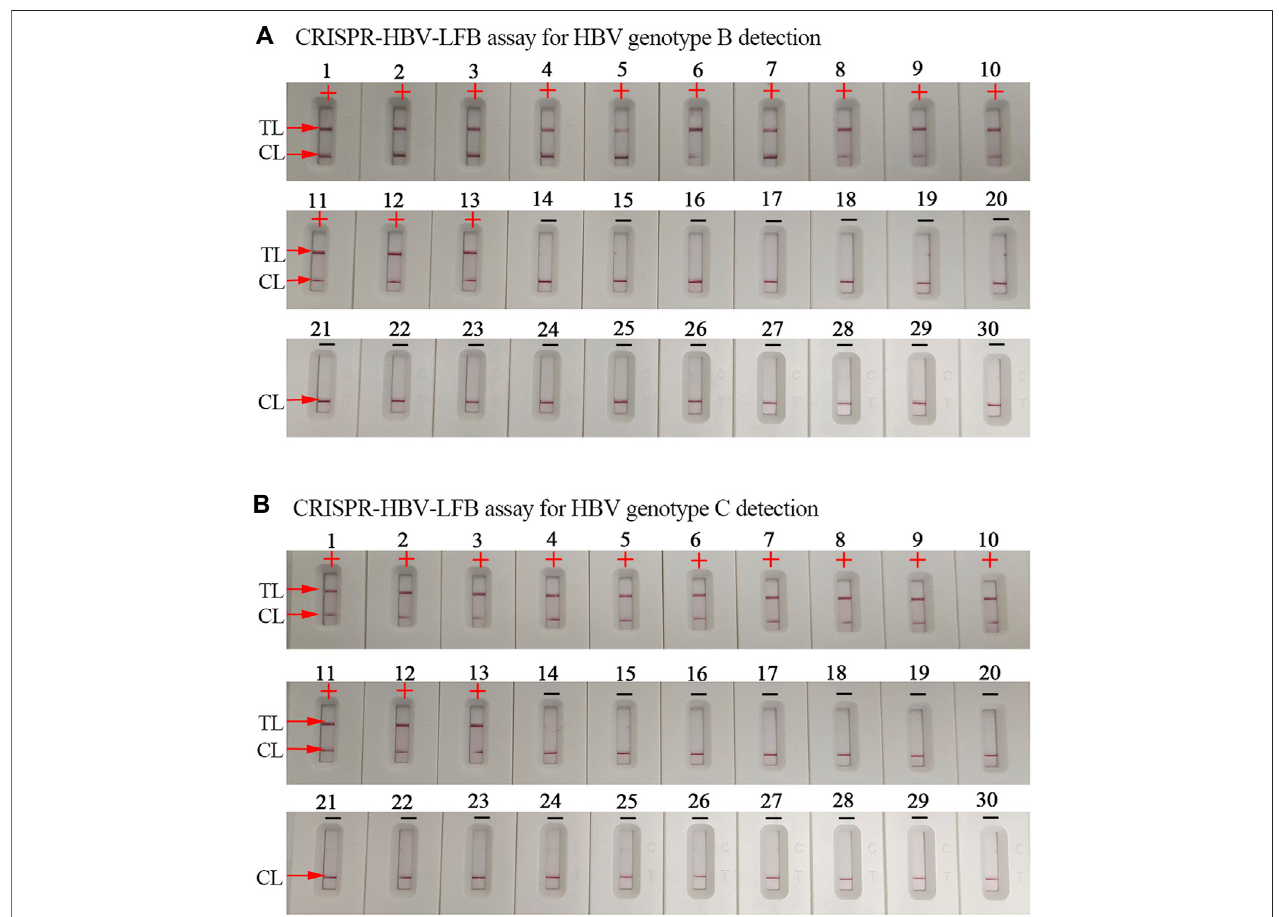
FIGURE 5 | The speci fi city of the CRISPR-HBV assay. (A) The speci fi city of the CRISPR-HBV – LFB assay for HBV genotype B detection. Biosensor 1, HBV genotype B- S plasmid; biosensors 2 – 9, HBV genotype B agents (clinical samples); biosensors 10 – 13, HBV genotype B/C agents (clinical samples); biosensor 14, HBV genotype A- S plasmid; biosensor 15, HBV genotype C- S plasmid; biosensor 16, HBV genotype D- S plasmid; biosensor 17, HBV genotype E- S plasmid; biosensor 18, HBV genotype F- S plasmid; biosensor 19, HBV genotype G- S plasmid; biosensor 20, HBV genotype H- S plasmid; biosensor 21, hepatitis C virus (standard substance); biosensor 22, human immunode fi ciency virus (standard substance); biosensor 23, human rhinovirus; biosensor 24, adenovirus; biosensor 25, Mycobacterium tuberculosis ; biosensor 26, Bordetella pertussis ; biosensor 27, Bacillus cereus ; biosensor 28, Haemophilus in fl uenzae ; biosensor 29, Staphylococcus aureus ;and biosensor30,blankcontrol.CL:controlline;TL:testline; “ + ” :positive; “ − ” :negative. (B) Thespeci fi cityoftheCRISPR-HBV – LFBassayforHBV genotypeC detection. Biosensor 1, HBV genotype C- S plasmid; biosensors 2 – 9, HBV genotype C agents (clinical samples); biosensors 10 – 13, HBV genotype B/C agents (clinical samples);biosensor14,HBVgenotypeA- S plasmid;biosensor15,HBVgenotypeB- S plasmid;biosensor16,HBVgenotypeD- S plasmid;biosensor17,HBVgenotype E- S plasmid;biosensor18,HBVgenotypeF- S plasmid;biosensor19,HBVgenotypeG- S plasmid;biosensor20,HBVgenotypeH- S plasmid;biosensor21,hepatitisC virus (standard substance); biosensor 22, human immunode fi ciency virus (standard substance); biosensor 23, human rhinovirus; biosensor 24, adenovirus;